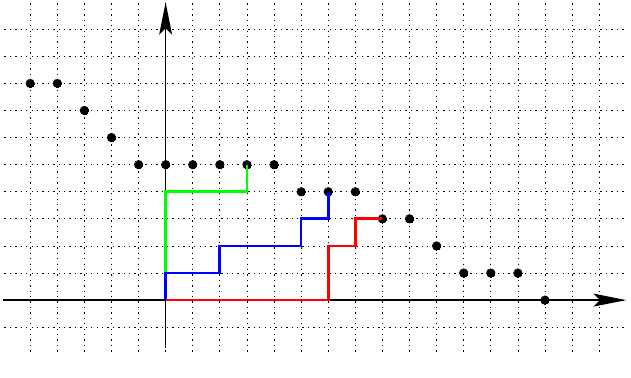
Fig. 2: A set V d,n with examples of walks in W d,n . Here n = 14 and d = (3 , 1 , 2 , 3 , 6 , 1 , 1 , . . .